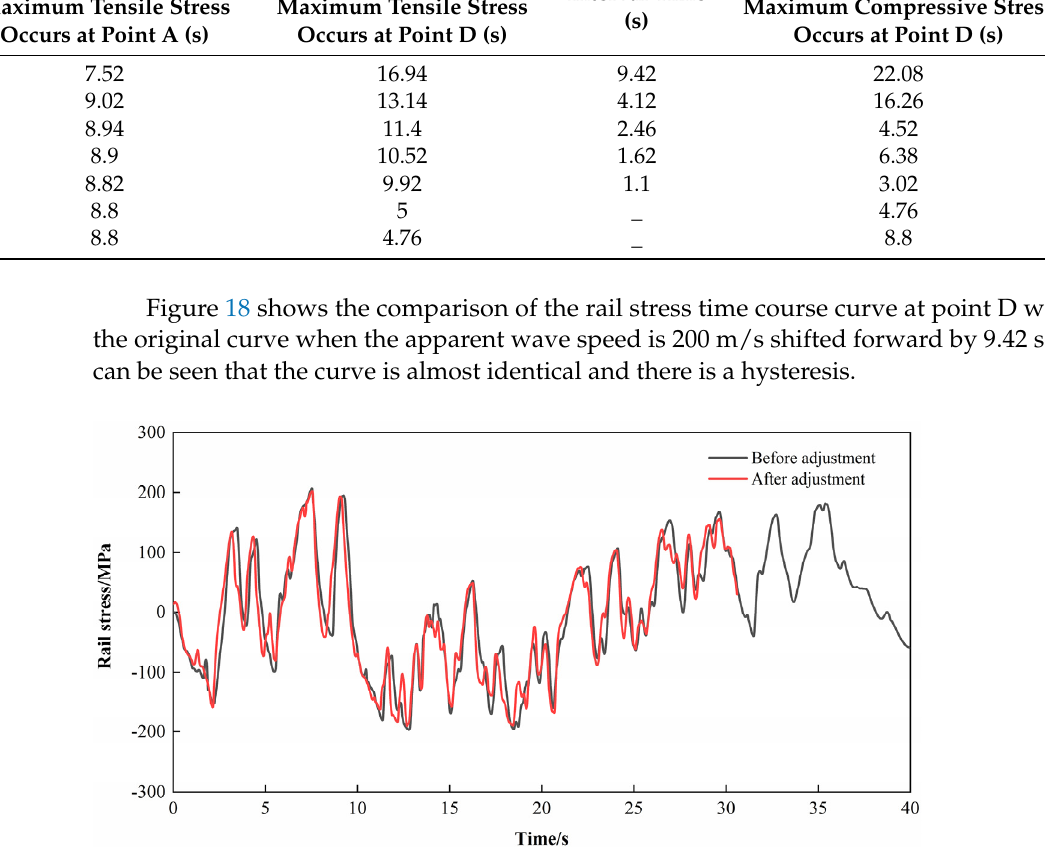
Figure 18. Comparison of curves before and after adjustment.